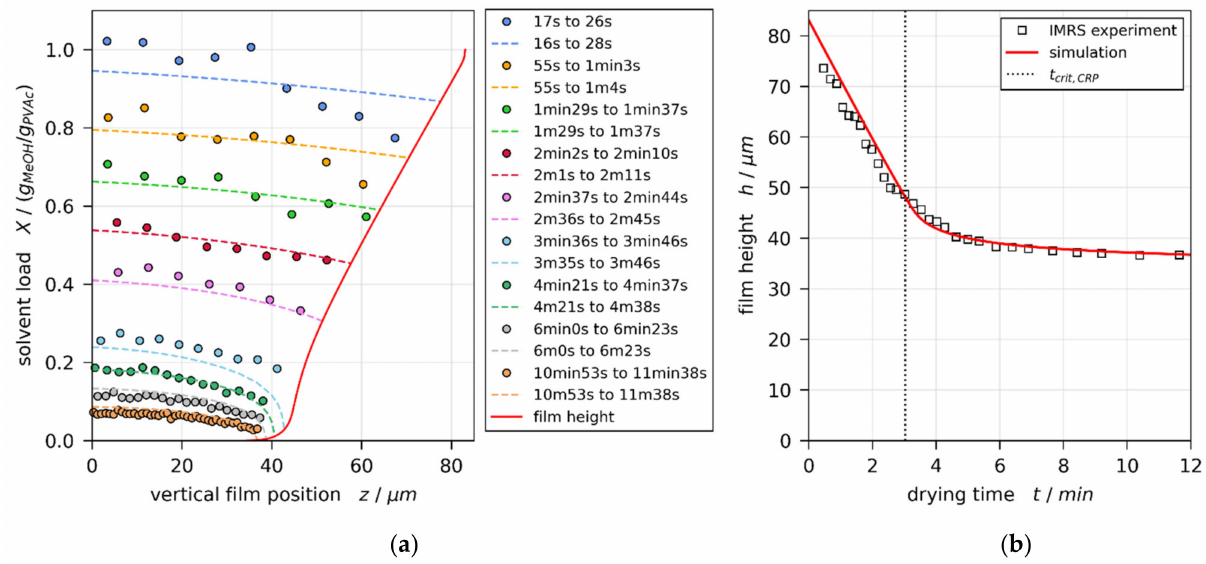
Figure 3. Comparison of experimental IMRS and best-matching simulation results for a drying poly (vinyl acetate)-methanol film ( X 0 = 1 g /g and h gap = 200 µ m, convectively stable according to Reference [1]), drying at T substrate = 20 °C MeOH PVAc and otherwise ambient conditions. The simulation was performed with experimental dry-film thickness and initial solvent load, as well as an effective upper heat-transfer coefficient α top =1.4 W/(m 2 · K). ( a ) Vertical solvent-load profiles at different drying times. Since IMRS is a scanning method, the acquisition time is given in ranges. This has been accounted for in the simulation. ( b ) Transient film height (drying curve) and end of constant rate period t crit , P